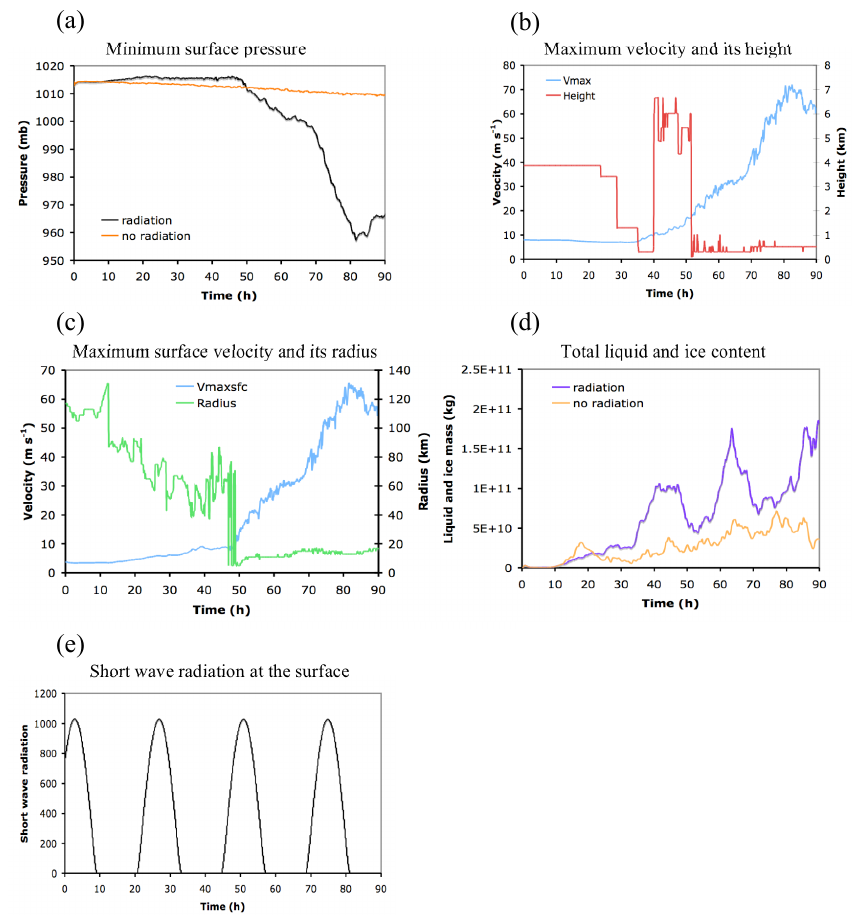
Fig. 11. Time series for Experiment 15. (a) Minimum surface pressure, including comparison with Experiment 6 that is the non-radiation case. (b) The azimuthally averaged maximum tangential velocity and the height it occurs. (c) The azimuthally averaged tangential velocity at the lowest model level and the radius it occurs. (d) Total liquid and ice mass content in a cylindrical volume of radius 100 km from the center including comparison with the non-radiation case. (e) Clear sky shortwave radiation at the surface. at t = 90 h (Fig.